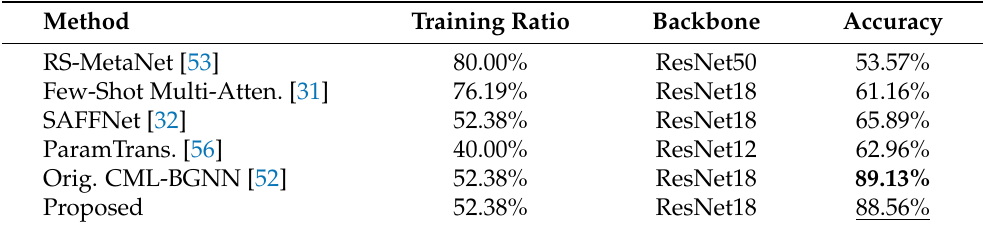
Table 4. Classification accuracies on UC Merced.